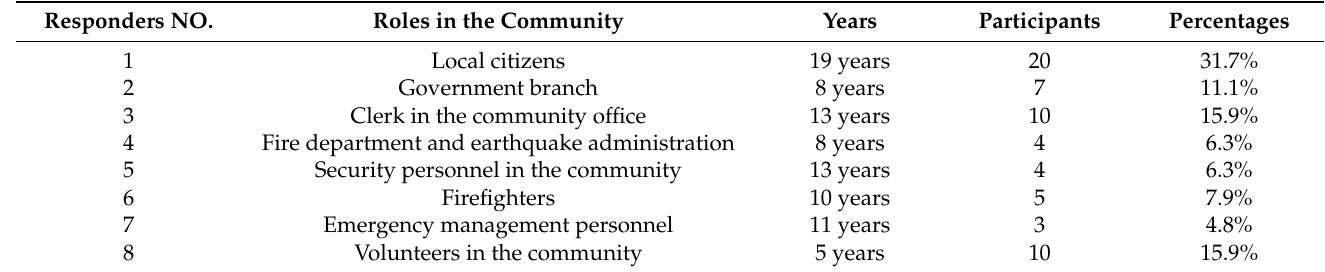
Table 2. Profiles of the responders.